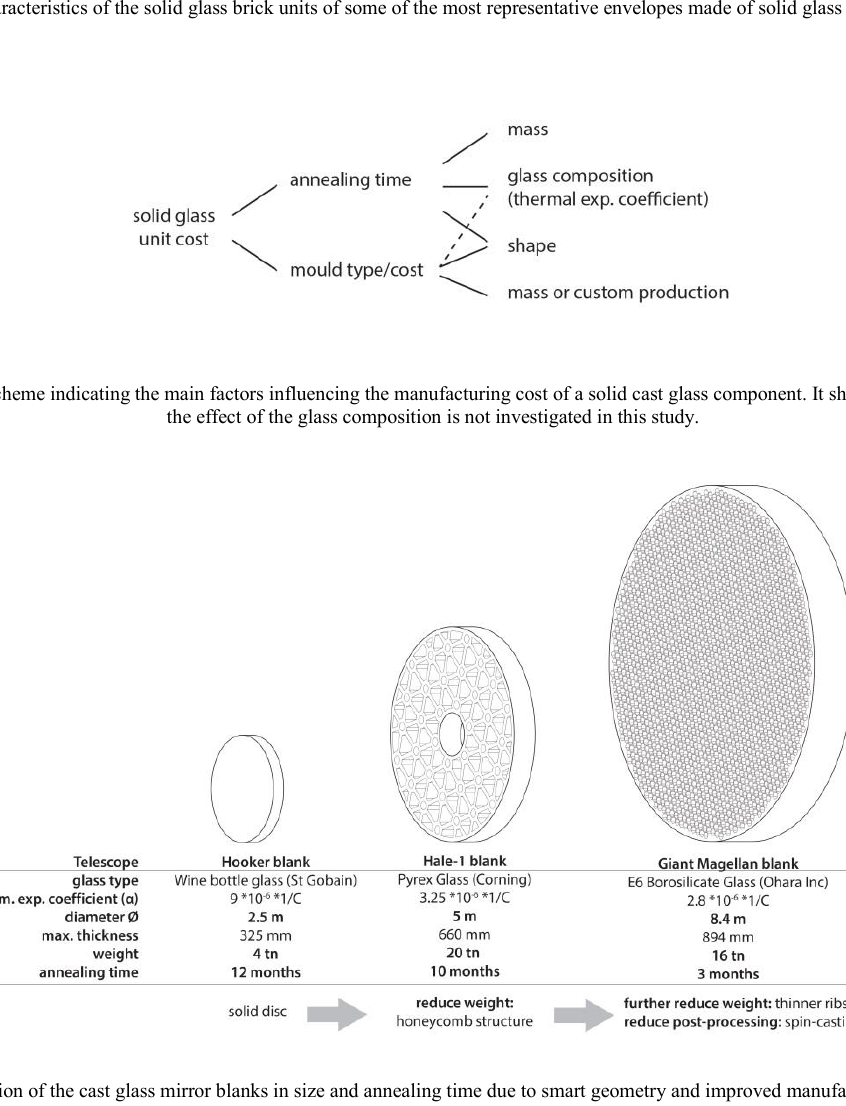
Fig. 3 Evolution of the cast glass mirror blanks in size and annealing time due to smart geometry and improved manufacturing process, derived from (Oikonomopoulou 2019), based on data from (Zirker